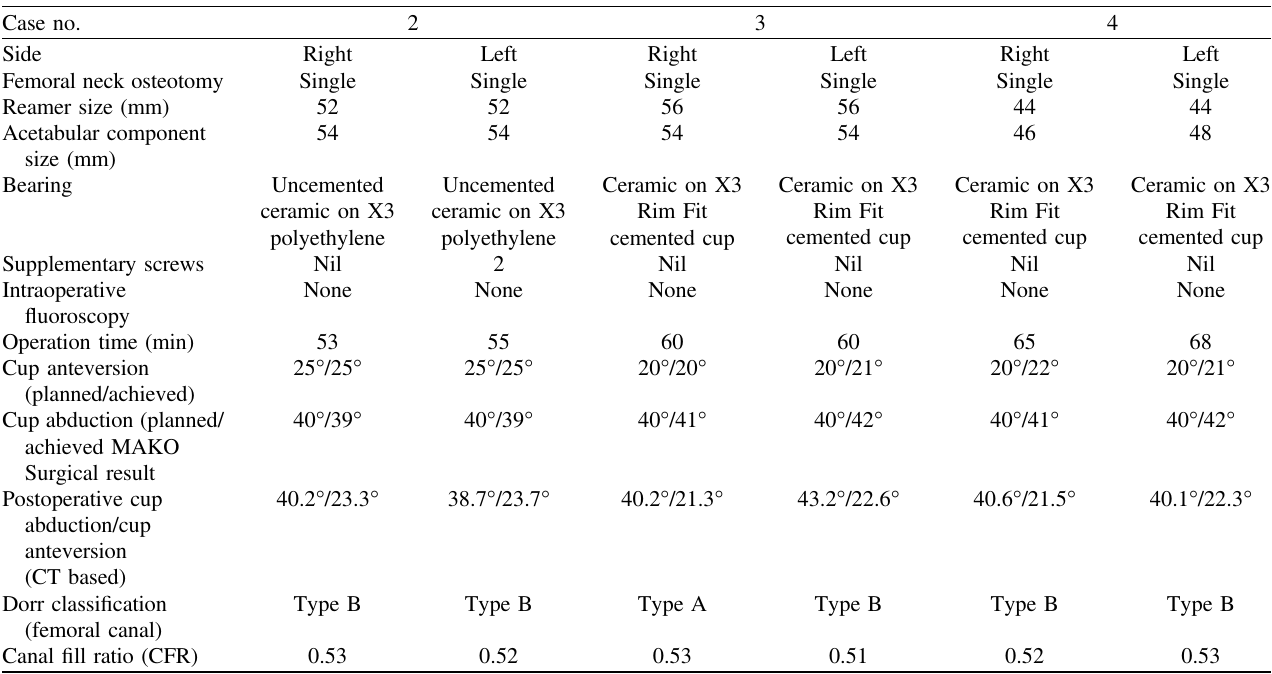
Table 2. Key RTHA